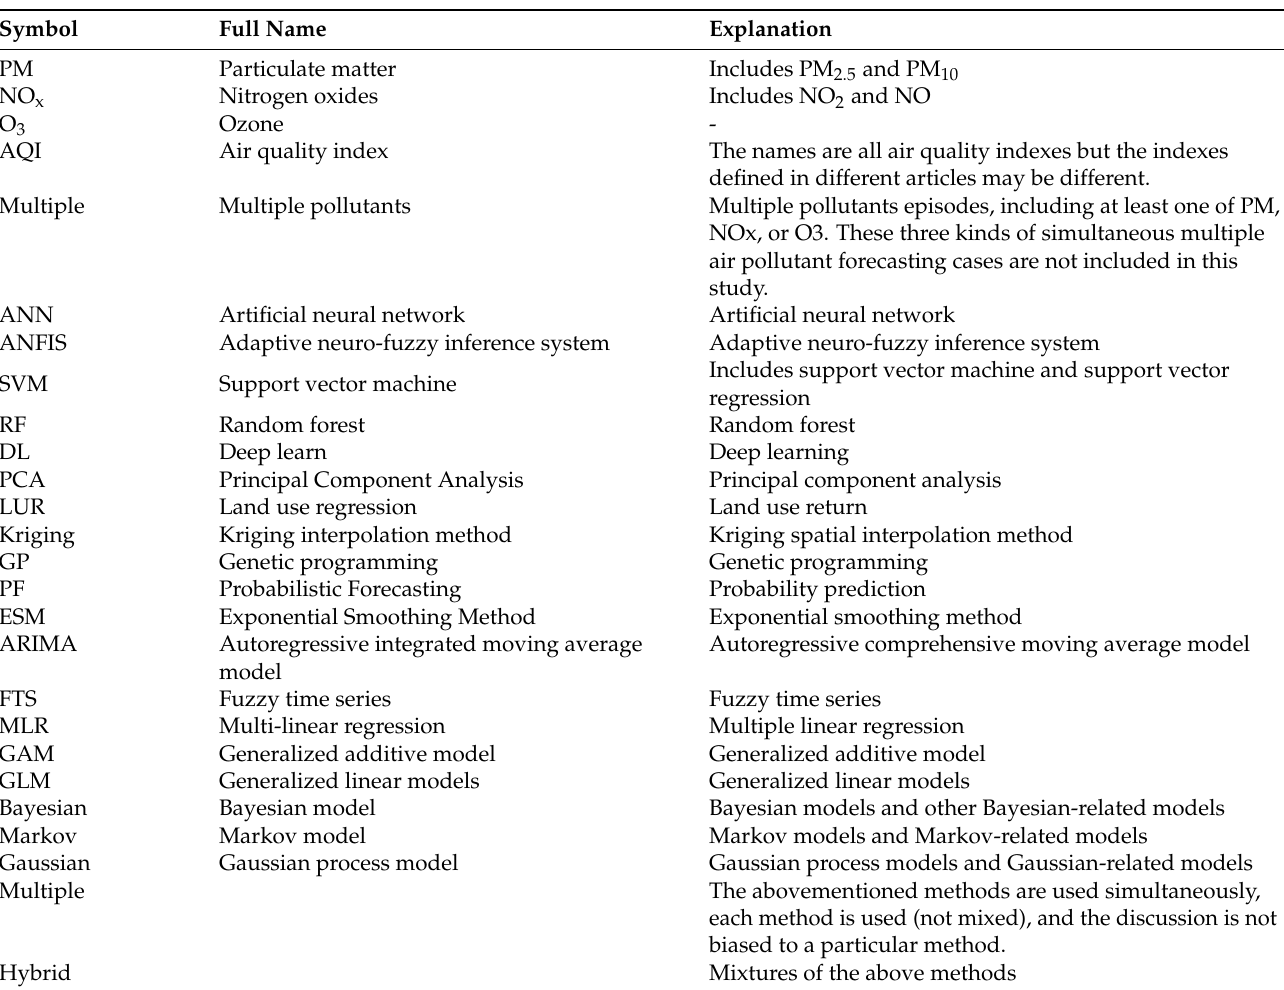
Table A3. Classification rules of the evolutionary